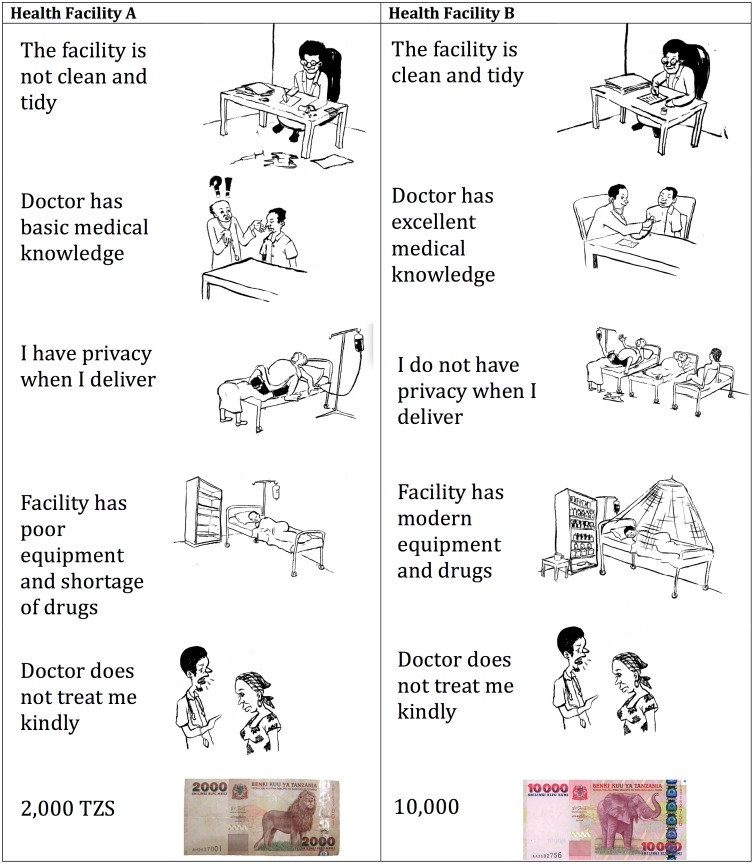
Sample DCE scenario card, 2012.